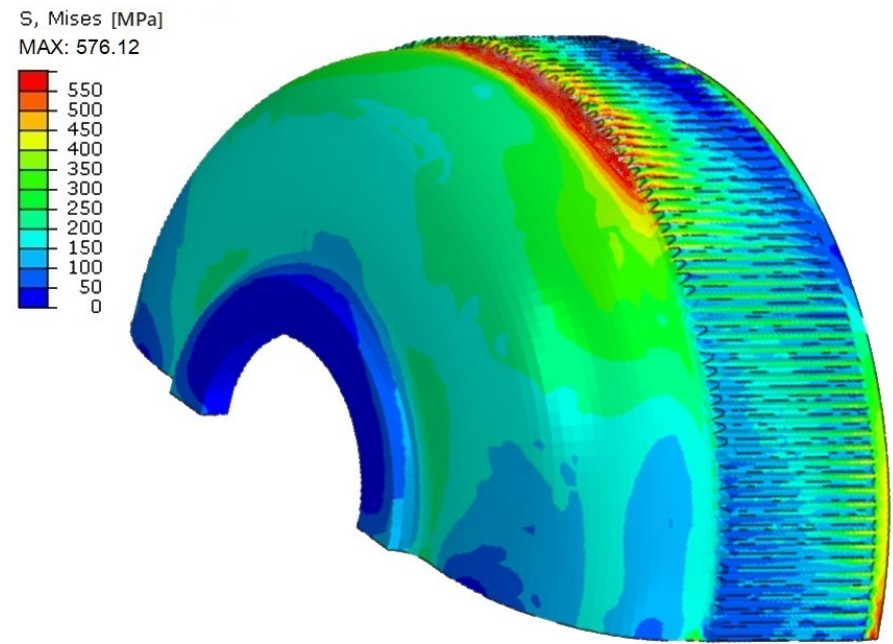
Figure 8. The distribution of the stresses in the flexspline model—variant IV.